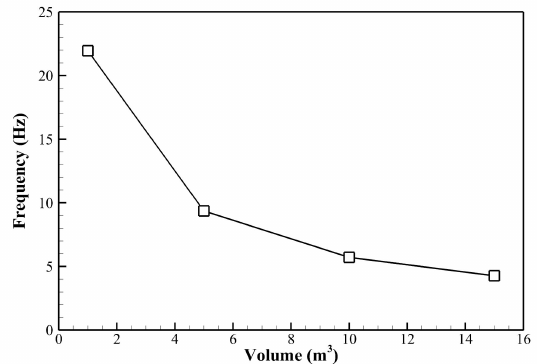
Figure 21. The relationship between the surge frequency and the volume of the